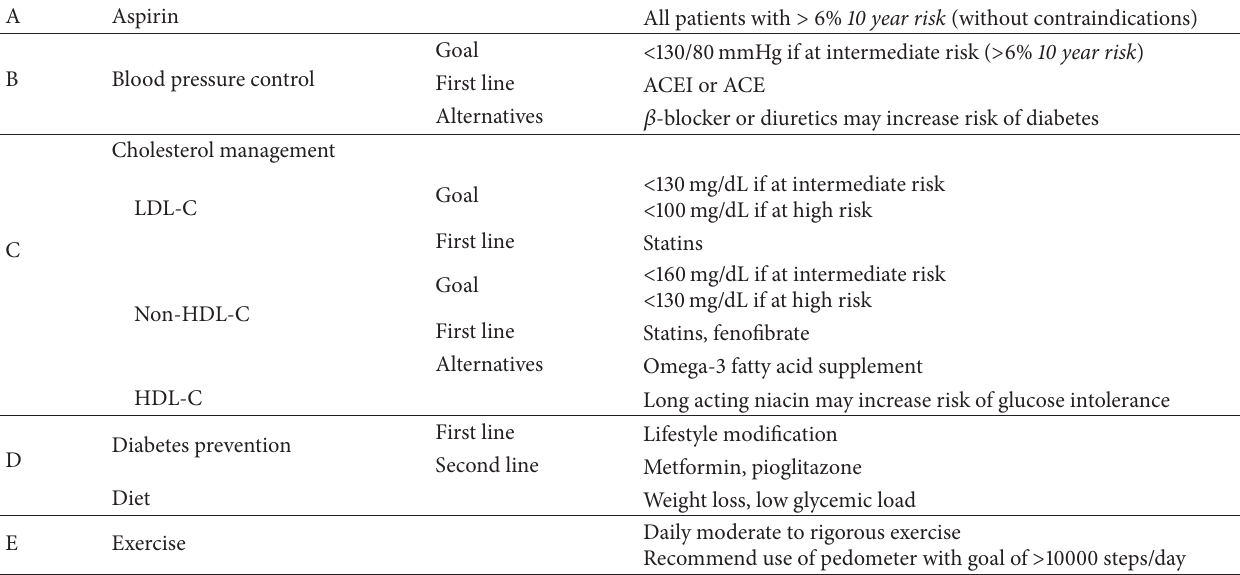
Table 3: ABCDE approach to managing metabolic syndrome